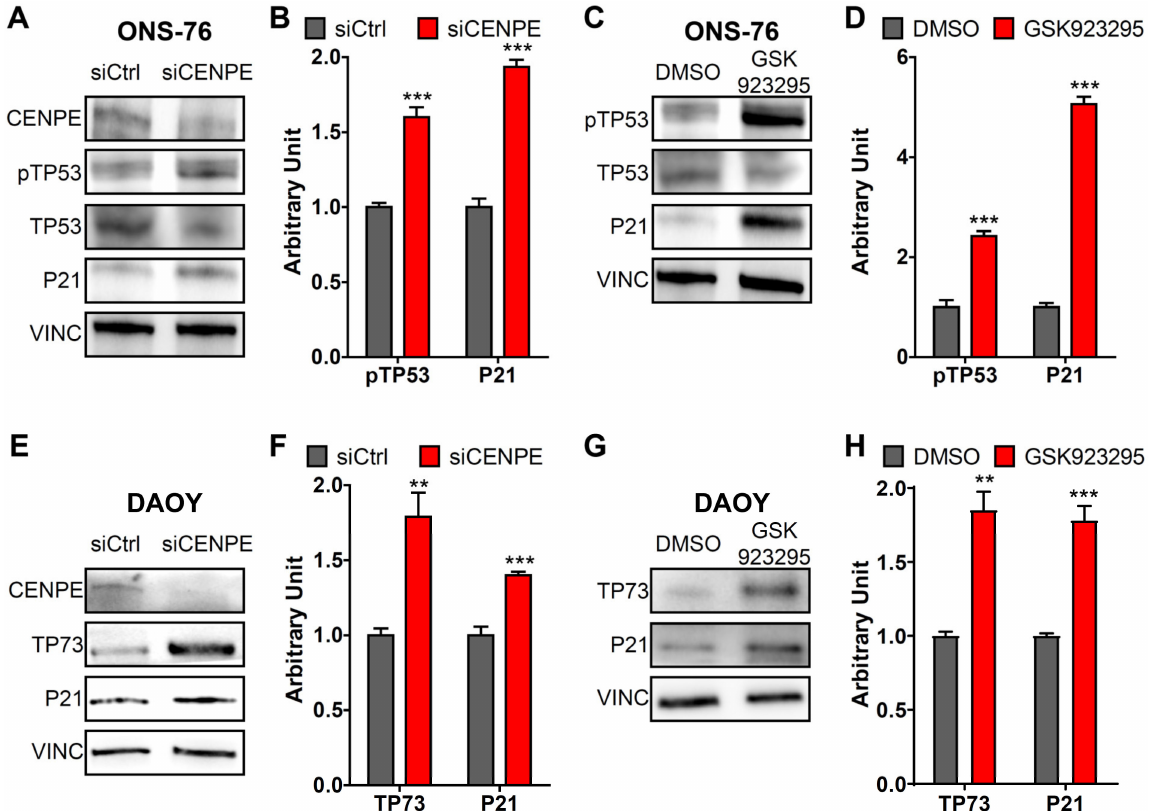
Figure 7. CENPE depletion or inhibition induces TP53 or TP73 pathway. ( A , B ) Western blot analysis and quantification of total lysate from ONS-76, 48 h after treatment with the indicated siRNAs. The levels of phospho-Ser15-TP53 (pTP53) and P21 were analyzed, the internal loading control was vinculin (VINC). ( C , D ) Western blot analysis and quantification, performed as in panel A, of total lysate from ONS-76, 24 h after treatment with 25 nM GSK923295. ( E , F ) Western blot analysis and quantification of total lysate from DAOY, 48 h after treatment with the indicated siRNAs. The levels of TP73 and P21 were analyzed, the internal loading control was vinculin (VINC). ( G , H ) Western blot analysis and quantification, performed as in panel E, of total lysate from DAOY, 24 h after treatment with 25 nM GSK923295. All quantifications were based on at least four independent biological replicates. Error bars, SEM; **, p < 0.01; ***, p < 0.001; two-tailed Student t -test. The original images are shown in the Figures S1 and